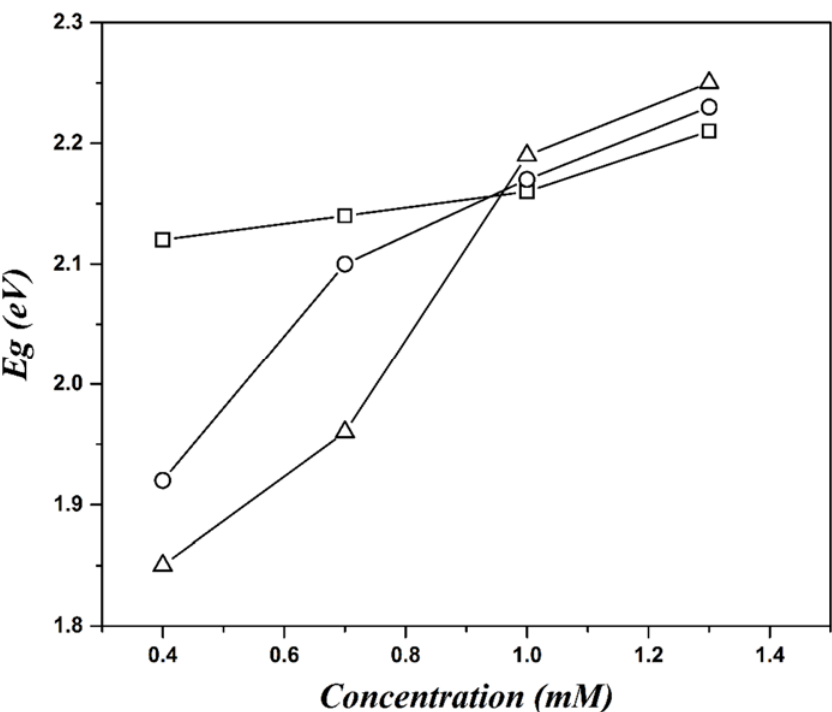
Figure 9. Eg energy of PVA films with self ‐ assembled/chitosan ‐ AuNPs/SWCNT ‐ COOH nanostructures as a function of the HAuCl 4 ∙ 3H 2 O concentration for different SWCNT concentrations (wt.%): ( □ ) 0.1, ( ○ ) 0.3 and ( Δ ) 0.5.